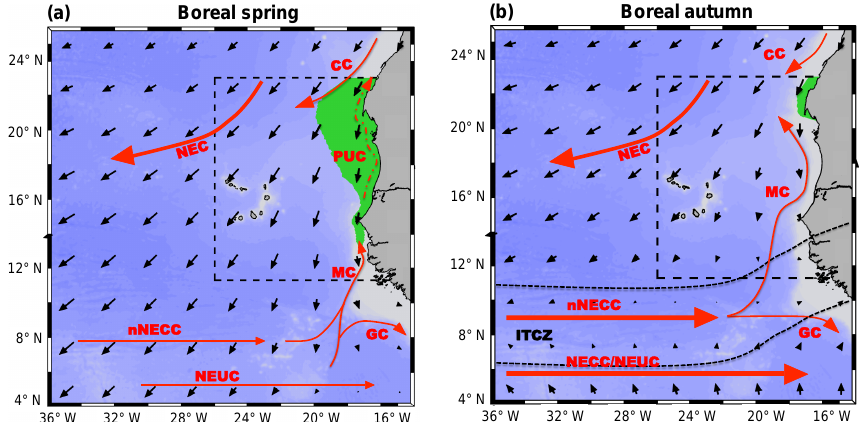
Figure 1. Schematic of the current system of the eastern tropical North Atlantic (red arrows; North Equatorial Current (NEC), Canary Current (CC), Poleward Undercurrent (PUC), Mauretania Current (MC), North Equatorial Countercurrent (NECC), Guinea Current (GC), North Equatorial Undercurrent (NEUC)) (a) in boreal spring and (b) in boreal autumn. Black arrows are mean wind vectors, green areas indicate seasonal mean SST<21 ◦ C. Blue colors represent topography and the dashed box indicates the TANWA area. The mean position of the Intertropical Convergence Zone (ITCZ) in autumn is indicated as the region bounded by the two black dashed lines in (b) .